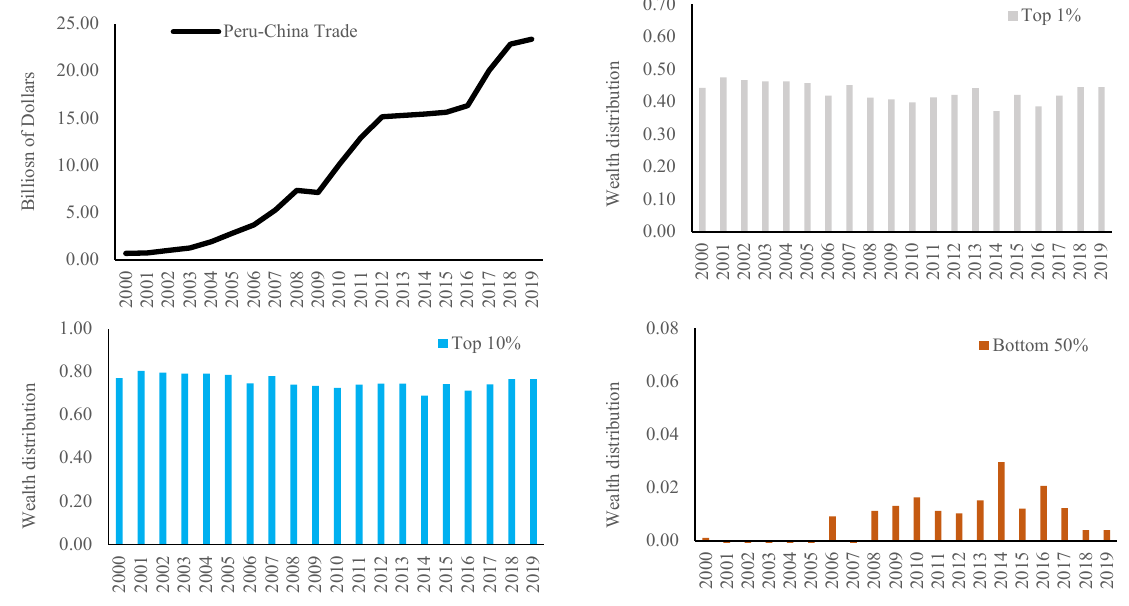
Fig. 3. Wealth Distribution and Peru – China Trade